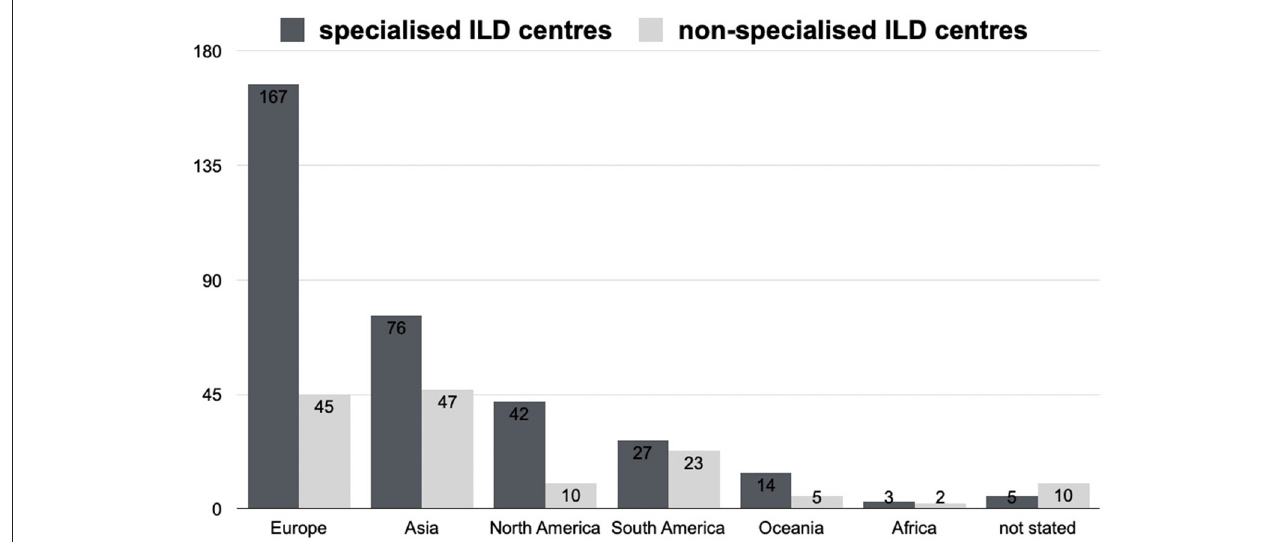
FIGURE 1 | Number of participants in specialised and non-specialised ILD centres from different continents.